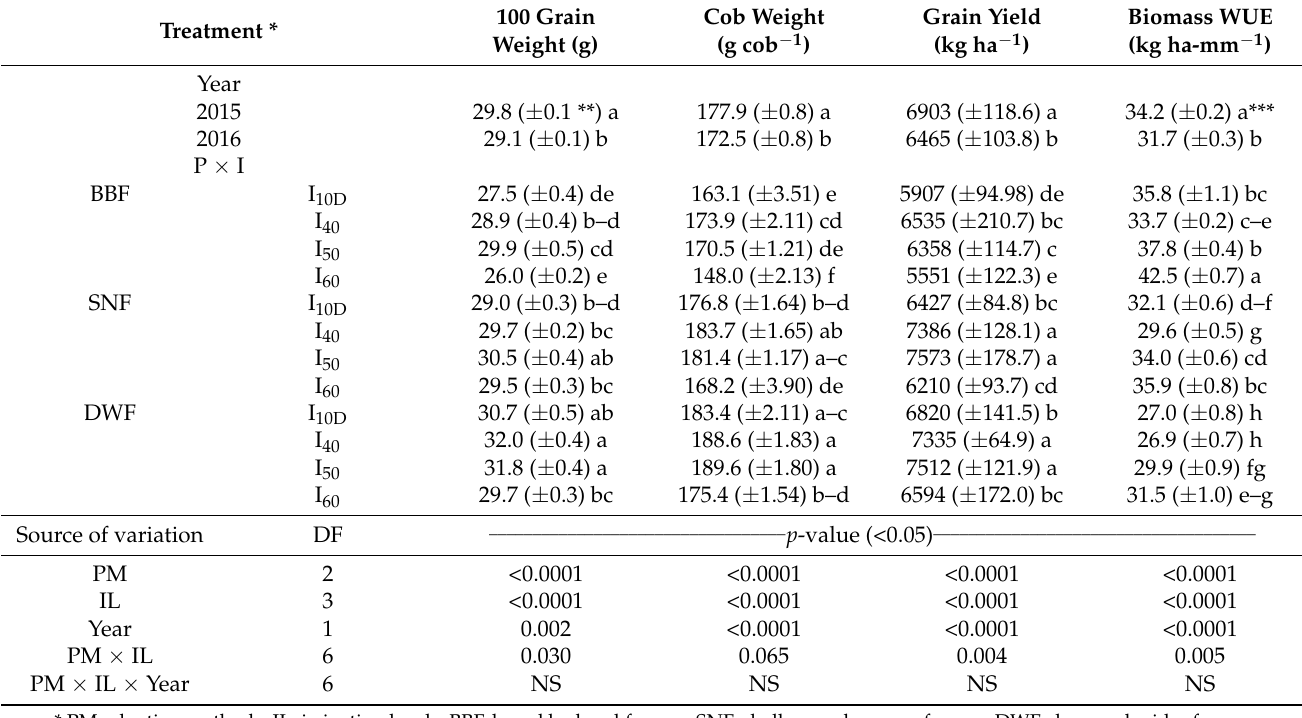
Table 8. Effect of planting methods, irrigation levels and year on 100 grain weight, cob weight, grain yield and biomass WUE of maize at Dharwad,